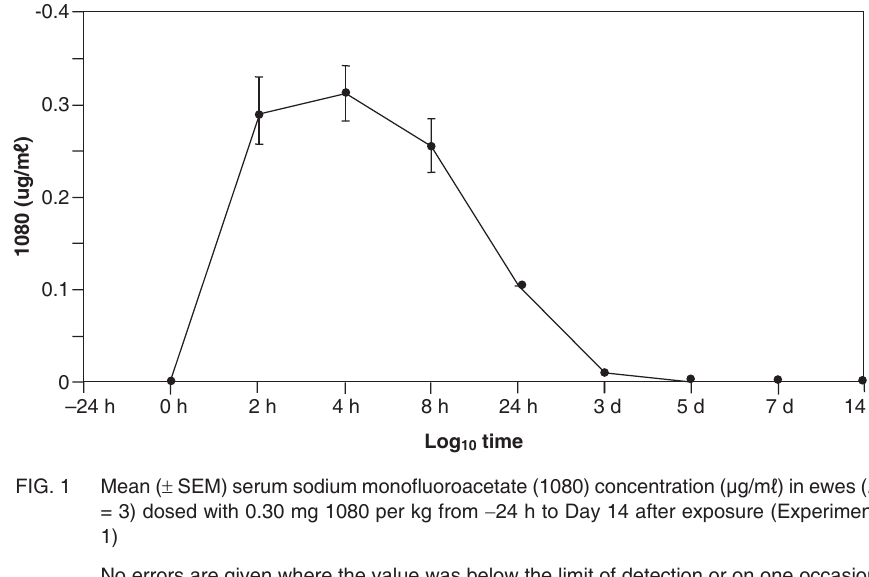
FIG. 1 Mean ( ± SEM) serum sodium monofluoroacetate (1080) concentration ( μ g/m ℓ ) in ewes ( n = 3) dosed with 0.30 mg 1080 per kg from − 24 h to Day 14 after exposure (Experiment